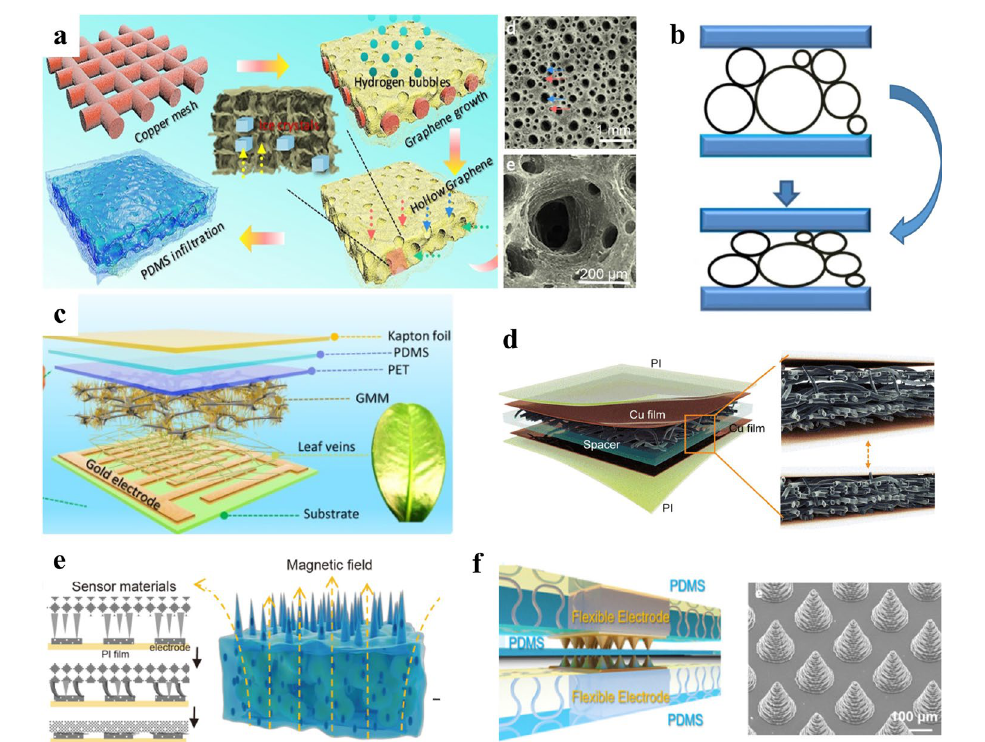
Fig. 4 Typical design strategies of flexible pressure sensors. a Hierarchically porous graphene structures [107]. Copyright (2019) American Chemical Society. b Conducting polymer films with hollow-sphere microstructures [106]. Copyright (2014) Springer Nature. c A